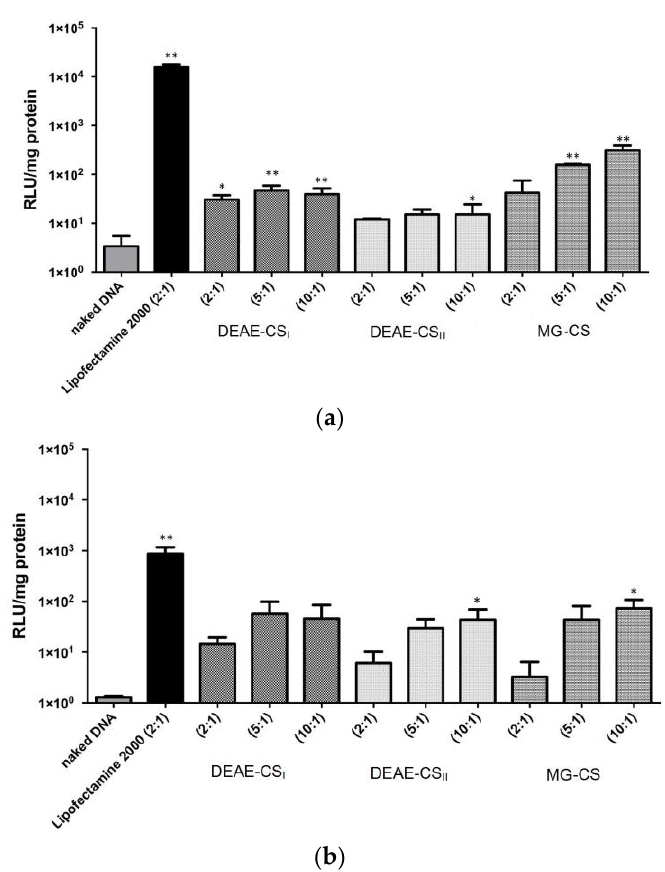
Figure 7. Transfection of Calu-3 ( a ) and JAWSII ( b ) cell lines. Values are the mean ± standard deviation; n = 3. Statistical analysis is presented in Table A1; * p < 0.05; ** p < 0.01.